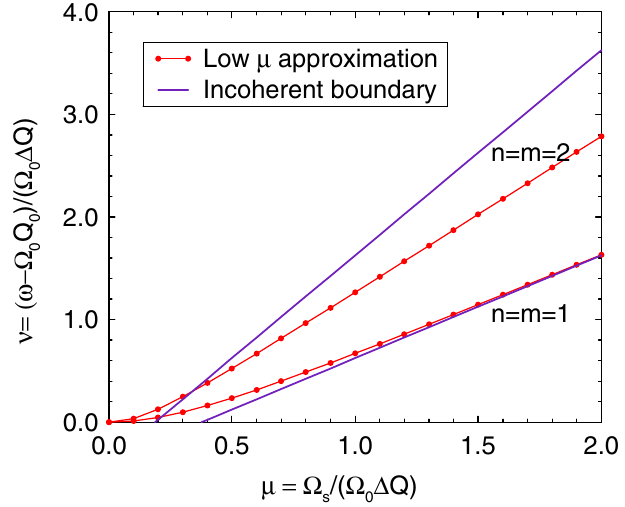
FIG. 16. (Color) Low- (cid:7) eigenvalues and incoherent boundaries of the ‘‘superparabolic’’ bunch. The continuous high- (cid:7) spectrum lies below the blue lines.